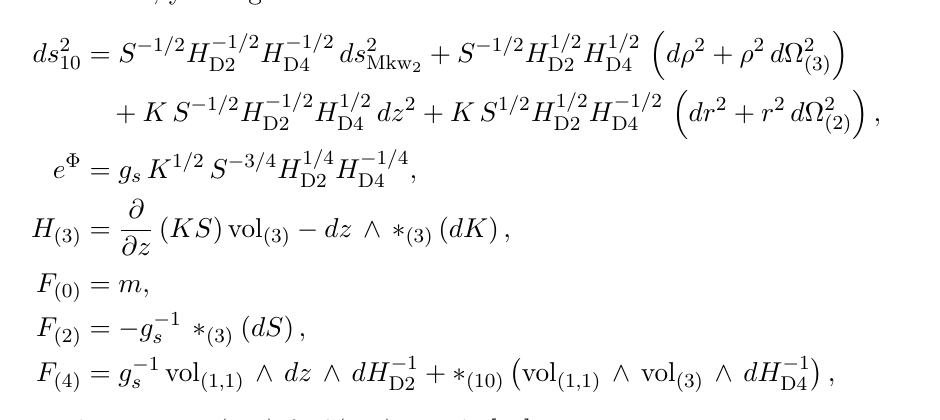
Table 2 . The brane picture underlying the 2d SCFT described by D2- and D4-branes ending on an NS5 { D6 { D8 funnel. The above system is 1 D2- & D4-branes,